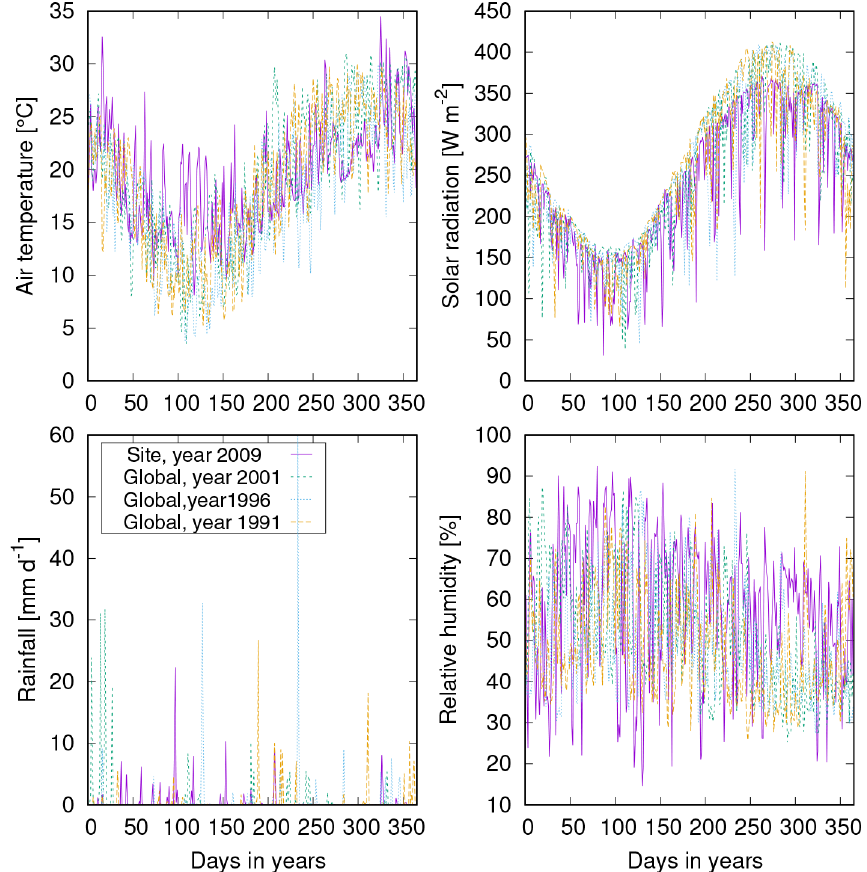
Figure A6. Comparison of climate data measured at one of the four Soebatsfontein field sites to global climate data for the region including Soebatsfontein. Note that global data for the year 2009 were not available from the standard data set used for LiBry, which spans the years 1958 to 2001. Climate data for the other three field sites at Soebatsfontein are similar to the site shown here.